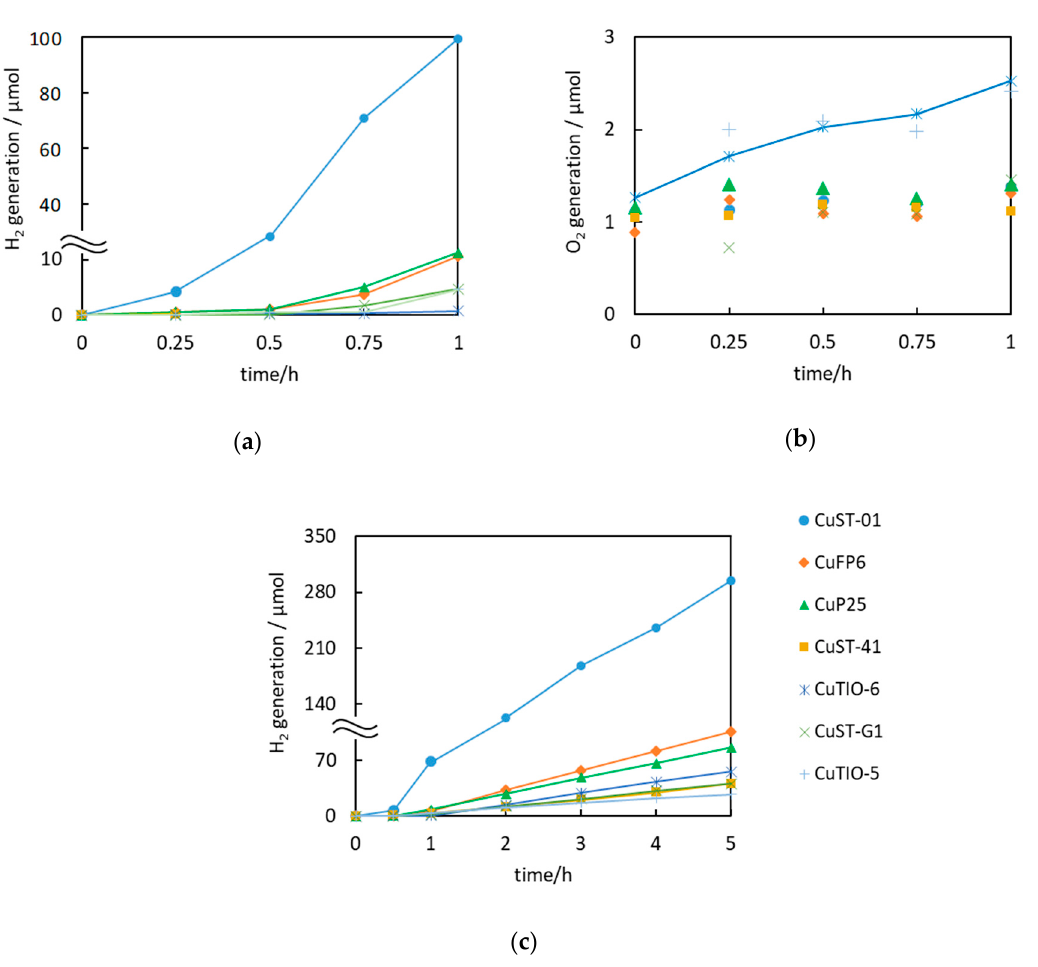
Figure 1. Hydrogen and oxygen evolution during the photodeposition of copper on titania: ( a ) in methanol/water for 1 h, ( b ) in water for 1 h, ( c ) in methanol/water for 5 h.